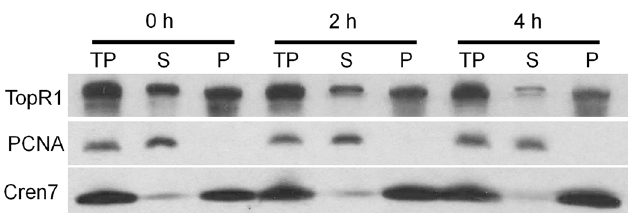
Figure 7. Western blot analysis of TopR1 level from cytoplasm fraction and chromatin-rich fraction during MMS treatment. S. islandicus Rey15A cells was treated with 2.6 mM MMS and cells were collected at 0, 2, and 4 h to prepare total protein (TP), cytoplasm fraction (supernatant, S) and chromatin-rich fraction (pellet, P). Antisera against PCNA3 and Cren7 were used as a loading control.